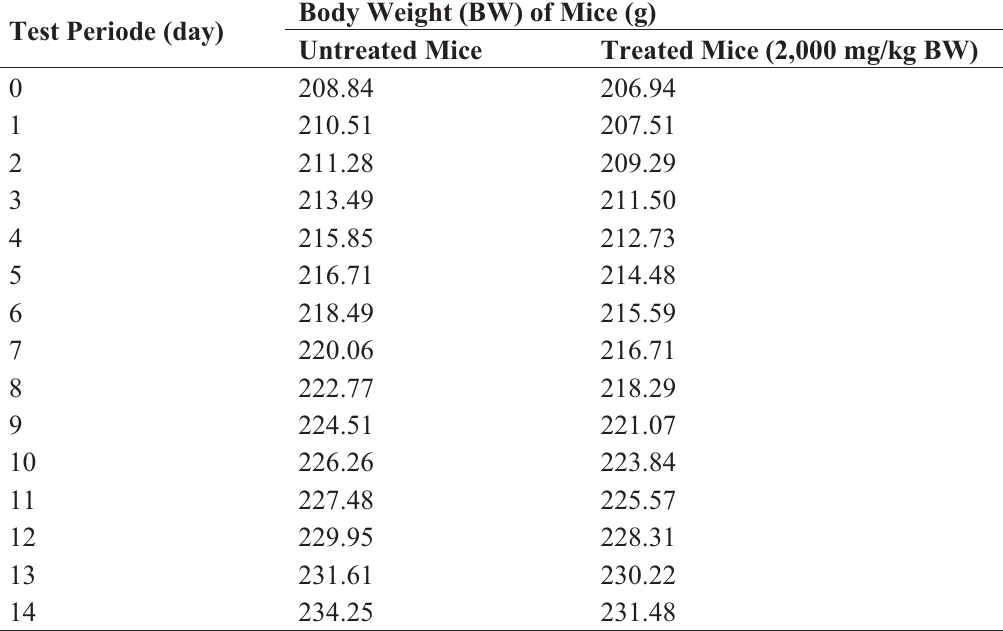
Table 4. Average weight loss group Sprague Dawley mice receiving treatment of acute dermal toxicity, after treated by C-C organic compound solution with a dose 2,000